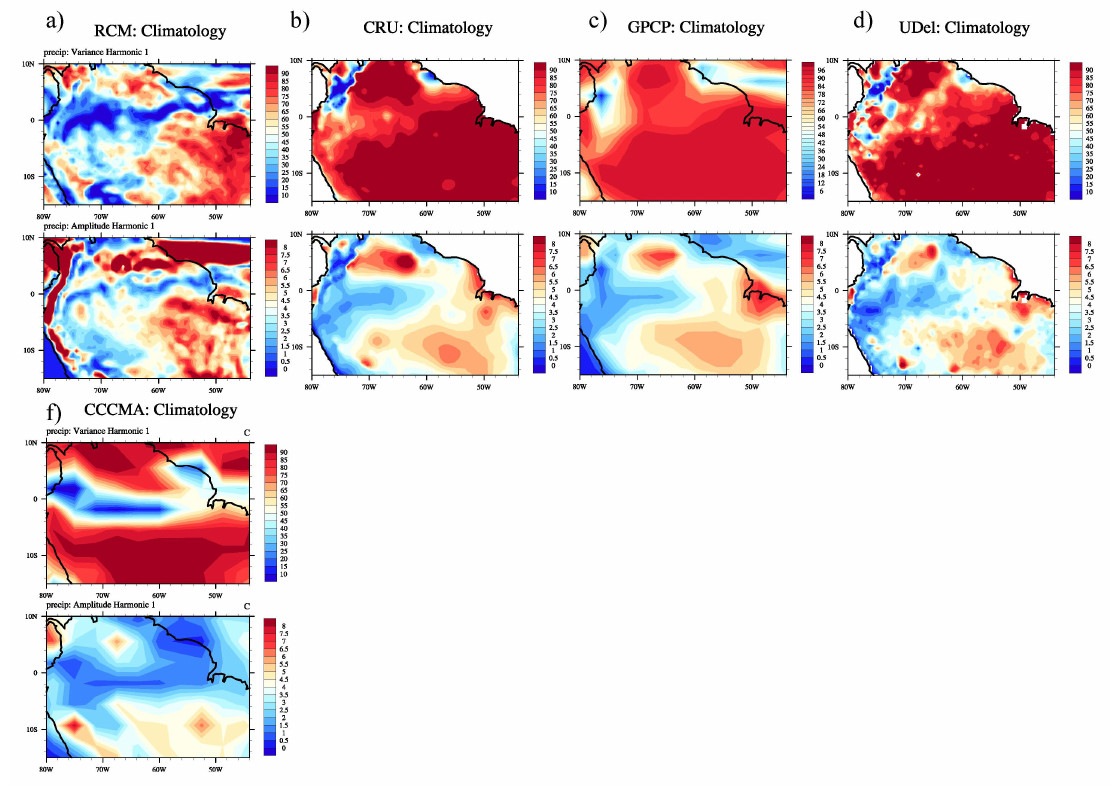
Figure 3. Explained variance (top panels %) and amplitude (lower panels ˝ C) of the first harmonic of precipitation. ( a ) PD-RCM simulation ( b ) CRU, ( c ) GPCP, ( d ) UDel, and ( e ) the